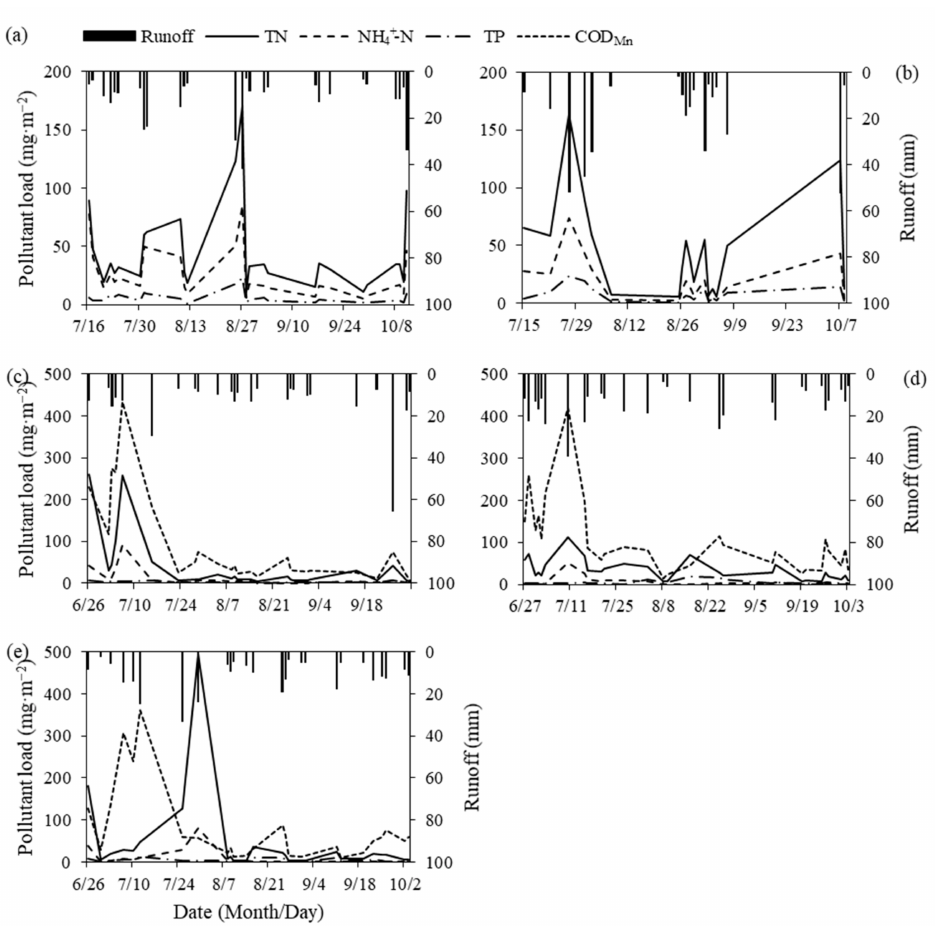
Figure 3. Runoff TN, NH 4 + -N, TP and COD Mn loads of paddy fields during the rice monitoring period. ( a ) LC13. ( b ) LC14. ( c ) ZT. ( d ) HQ. ( e )